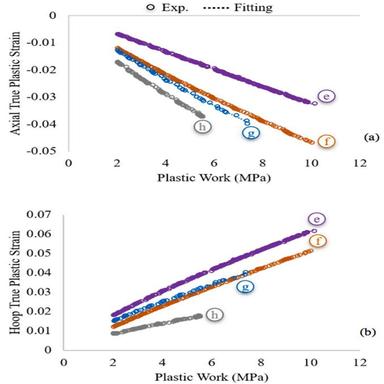
The calculated principal plastic strains for different levels of plastic work for tension-compression deformation modes: a) Axial plastic strain and b) Hoop plastic strain with respect to the plastic work (The experimental data were fitted using polynomial functions).